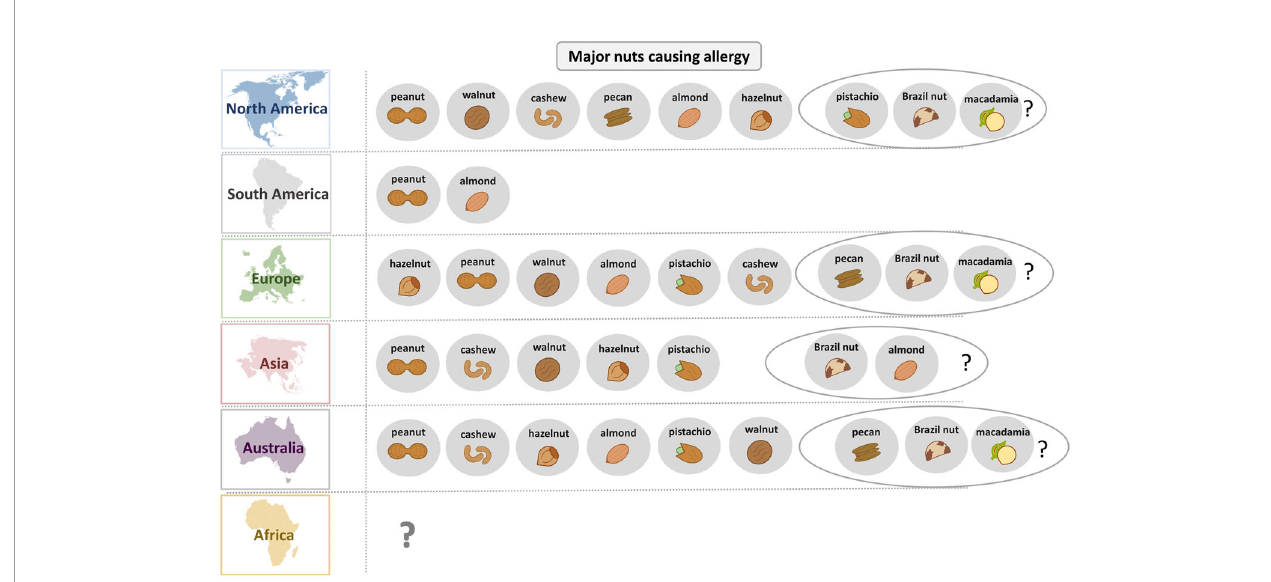
FIGURE 2 | Overview of the relevance of different nuts as allergen sources in different parts of the